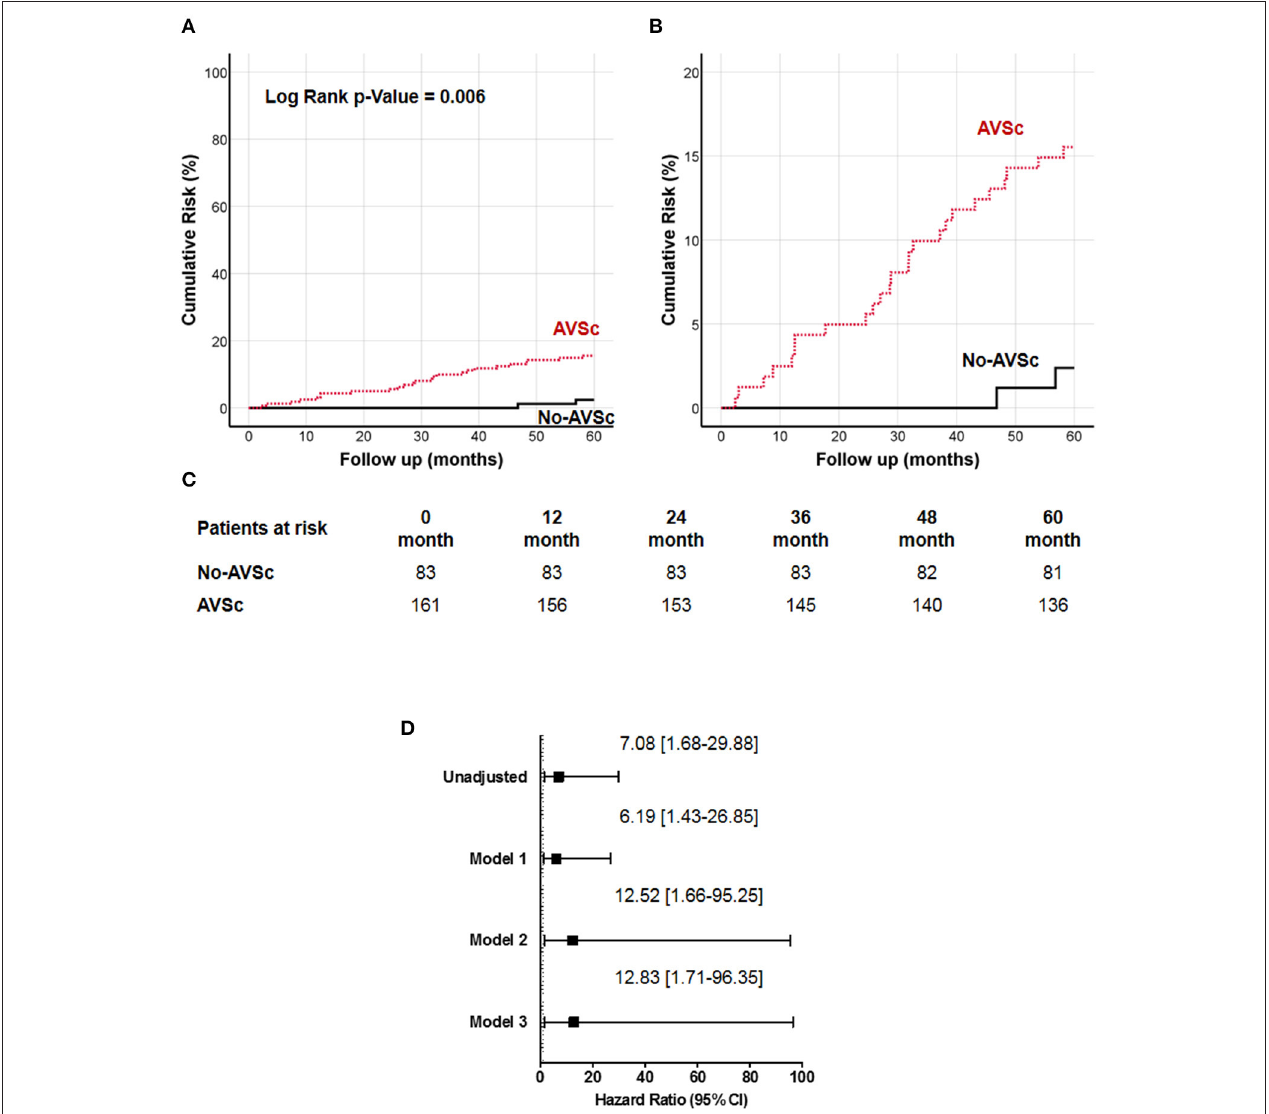
FIGURE 3 | Cumulative incidence curves for 5-year all-cause mortality in patients with mixed-fibrotic carotid plaque. (A) All-cause mortality was compared between CEA patients with (red dash line) and without (black solid line) aortic valve sclerosis (AVSc). (B) Inset of (A) to better evidence the differences between the two groups. (C) Breakdown of the patients at risk per year in the two groups. (D) Cox regression analysis showing the hazard ratio (HR) unadjusted and adjusted for age (Model 1), for age and estimated glomerular filtration rate (eGFR; Model 2), and for age, eGFR, and left ventricular ejection fraction (LVEF; Model